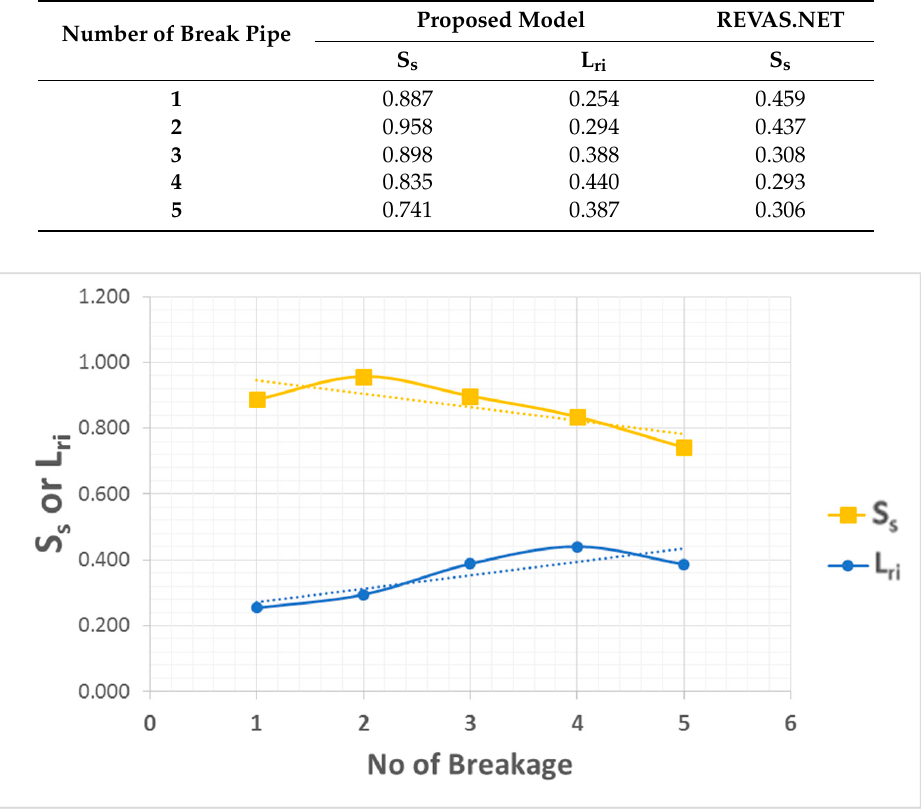
Figure 8. Comparison of the results of analysis of the indices of REVAS.NET according to the number of breakages.